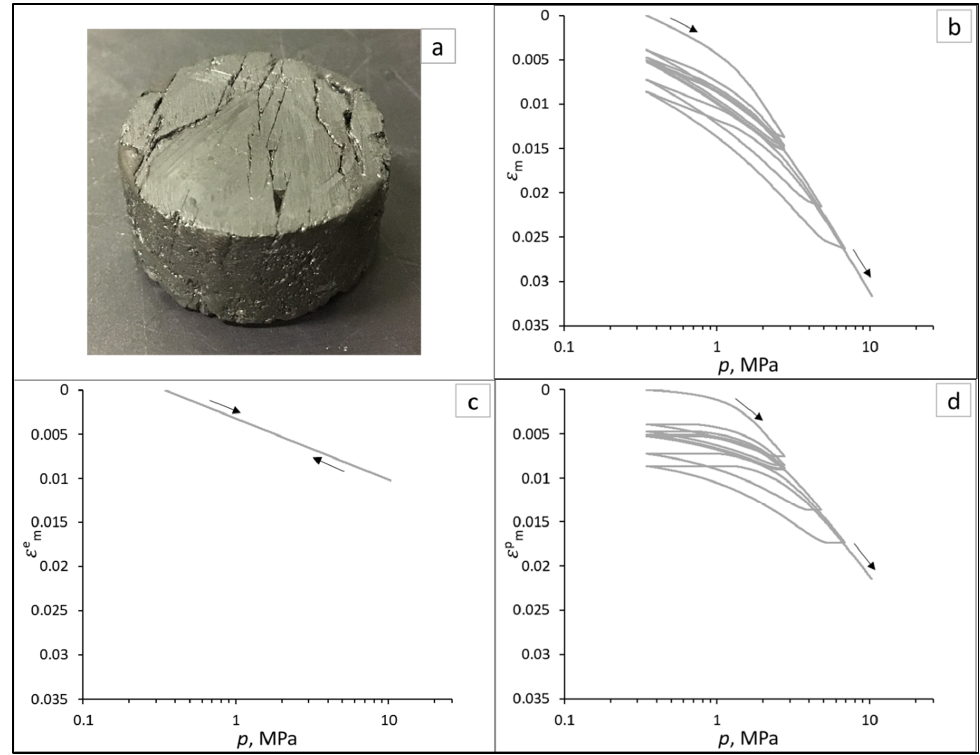
Figure 21. Photo and calculation of coal sample 4 (test